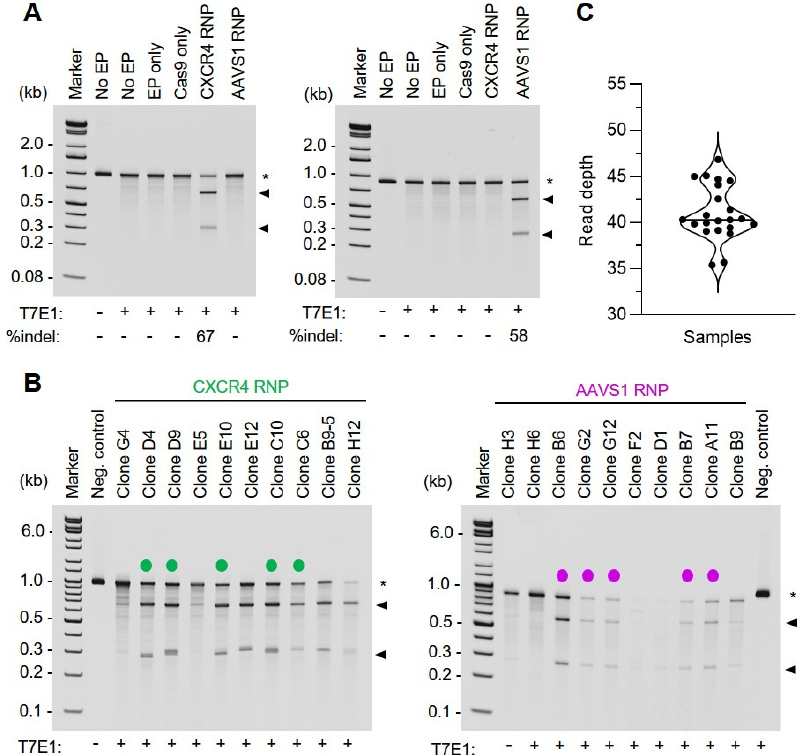
Figure 2. Characterization of CRISPR / Cas9 genome editing by T7 endonuclease I (T7E1) assay. ( A ) T7E1 analysis of CRISPR / Cas9-mediated gene editing in bulk HSPCs. For analysis of bulk (i.e., pre-clonal) HSPC gene editing e ffi ciency, genomic DNA (gDNA) was isolated from gene-edited and control HSPC samples at 3 days post-treatment. Isolated gDNA was subjected to PCR amplification using either CXCR4 (left panel) or AAVS1 (right panel) target site-specific primer sets as described in Materials and Methods. Where indicated, PCR amplicons were digested with T7E1, and enzymatic cleavage products were resolved by electrophoresis on a native 4–20% polyacrylamide gradient gel. Amplicon substrates are indicated by an asterisk (*), T7E1 cleavage products are indicated by arrowheads. Clonal isolates selected for WGS and variant analysis are indicated by a color-coded dot. ( B ) T7E1 analysis of CRISPR / Cas9-mediated gene editing in HSPC clonal isolates. For analysis of gene editing e ffi ciency in HSPC clonal isolates, gDNA was extracted from cellular colonies approximately 2–4 weeks post-treatment. Isolated gDNA was subjected to PCR amplification using either CXCR4 (left panel) or AAVS1 (right panel) target site-specific primer sets. Where indicated, PCR amplicons were digested with T7E1, and enzymatic cleavage products were resolved by native polyacrylamide gel electrophoresis (4–20% gradient gel). Amplicon substrates are indicated by an asterisk (*), T7E1 cleavage products are indicated by arrowheads. Clonal isolates selected for whole genome sequencing (WGS) and variant analysis are indicated by a color-coded dot. EP, electroporation; kb, kilobase pairs; sgRNA, single guide RNA. ( C ) WGS read depth. Violin plot showing read depth for each sample. The median (40.3 × ) is indicated by a black